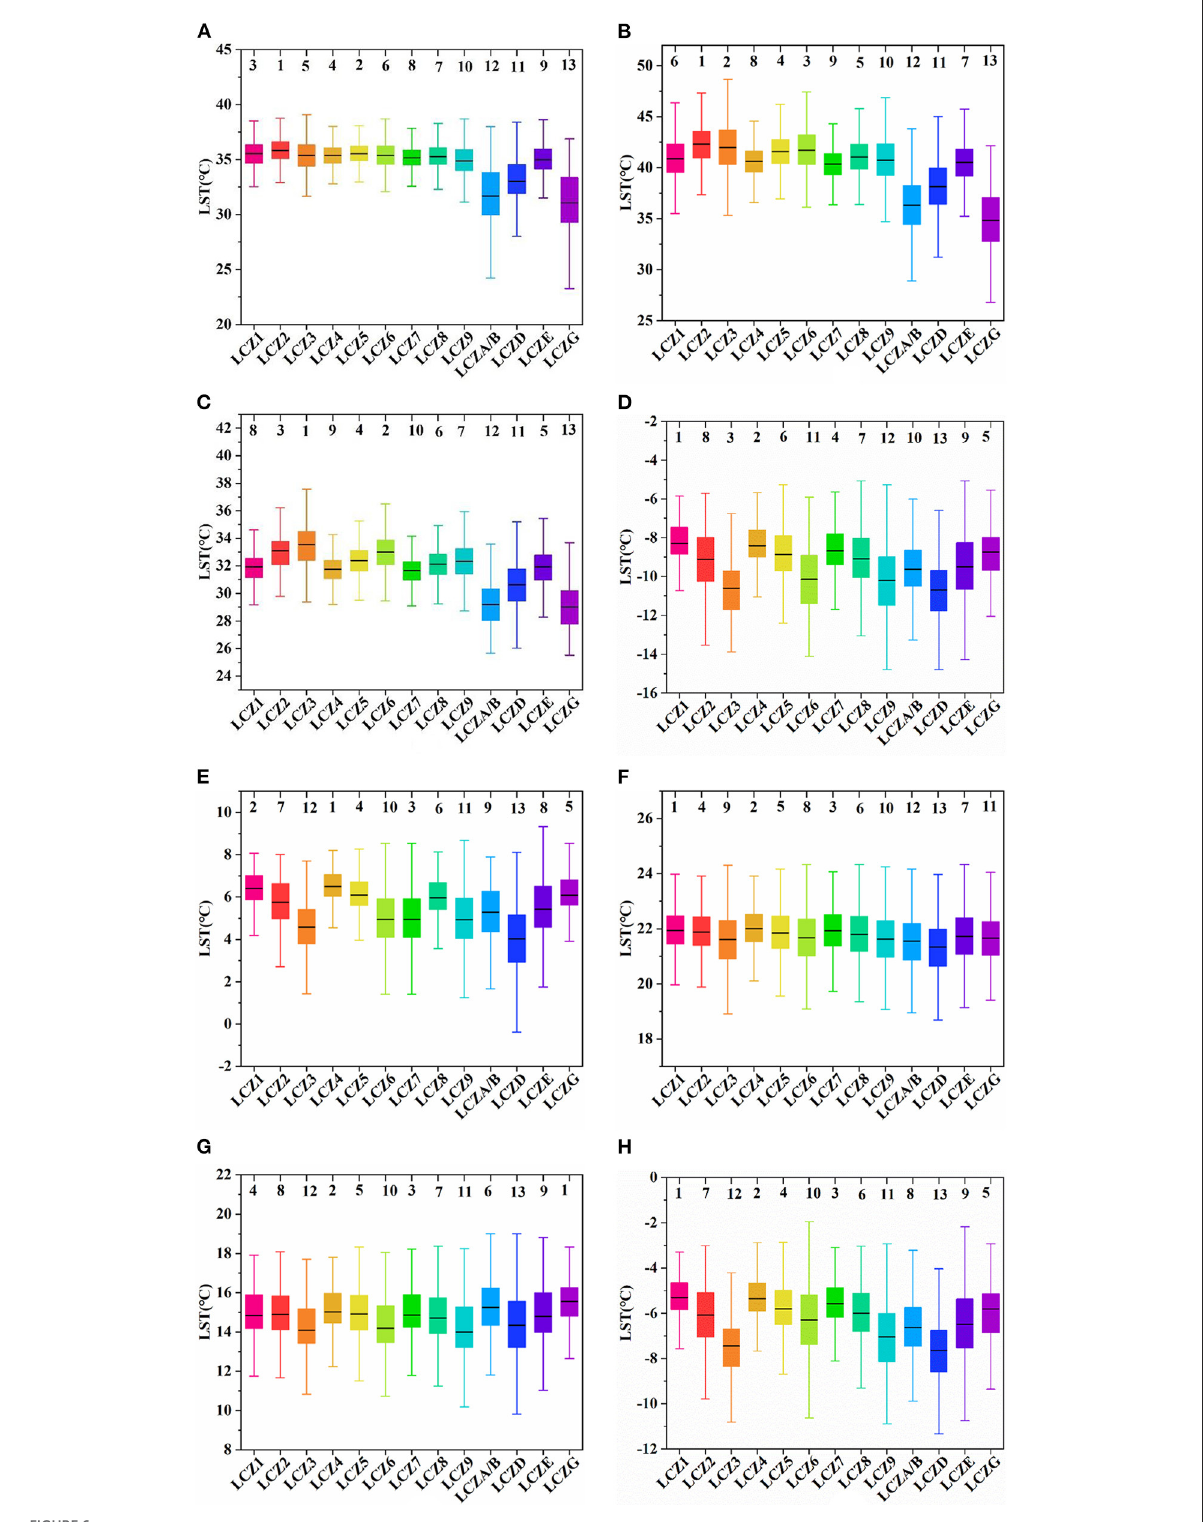
FIGURE6 (A–D) Box line plots for each daytime LCZ during spring, summer, autumn, and winter, respectively; (E–H) Box line plots for each night-time LCZ during spring, summer, autumn, and winter, respectively. The lines in the box represent the average, and the numbers above represent LCZs ranked according to average LST (the warmest to the coldest zones from 1 to